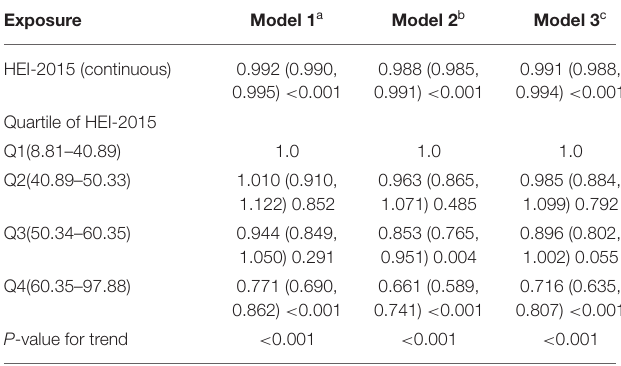
TABLE 2 | Association of Healthy Eating Index 2015 with kidney